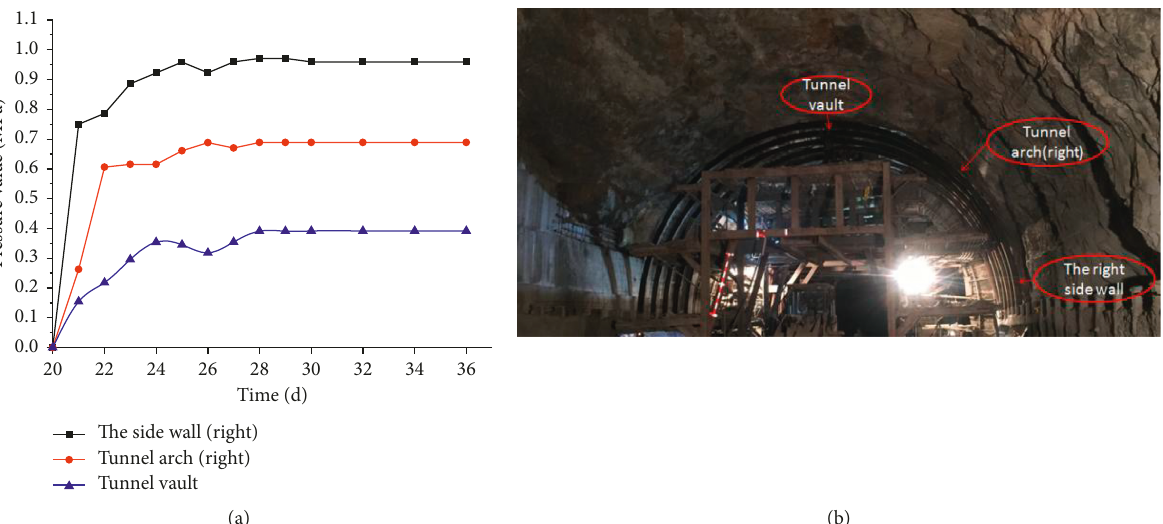
Figure 16: Displacement test of surrounding rock. (a) Change in surrounding rock and initial lining pressure of the K14+ 400 section. (b) Site